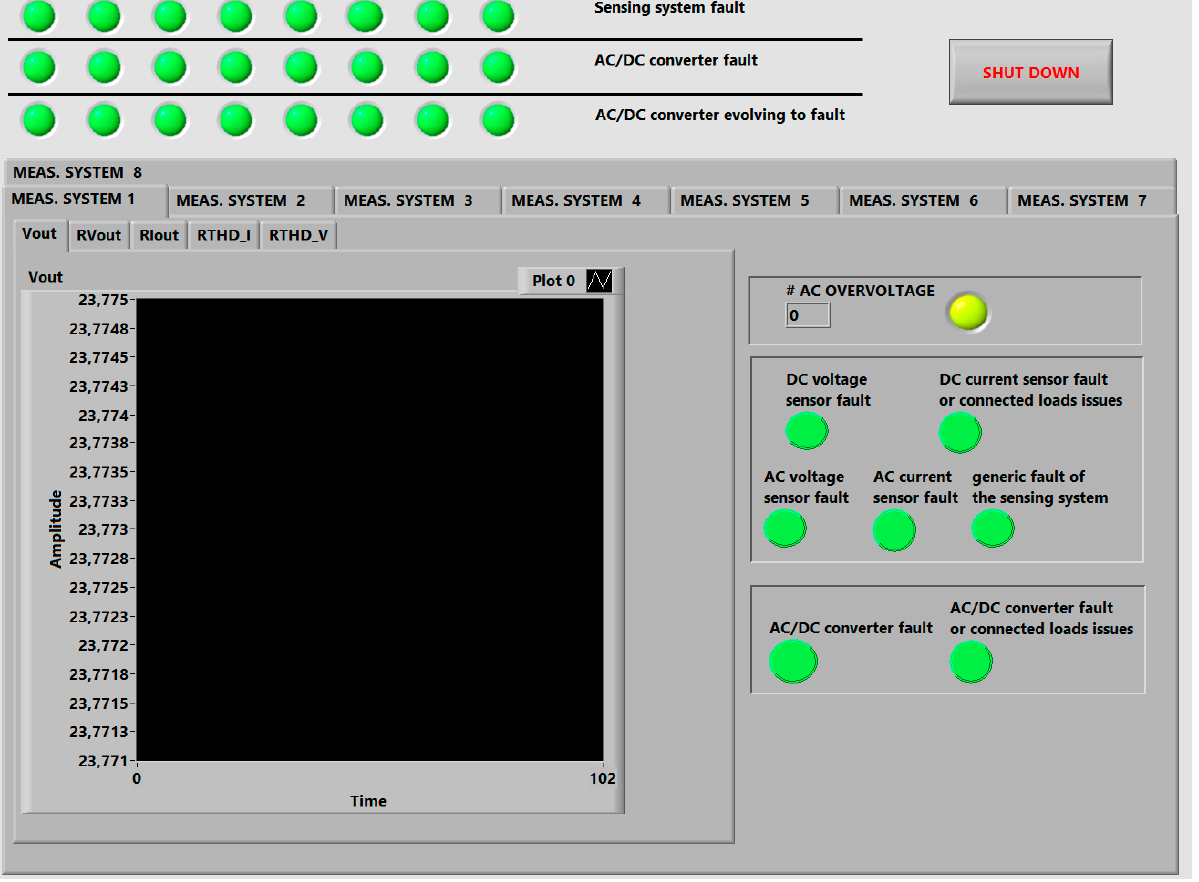
Figure 7. Front panel of the supervisor LabVIEW program.